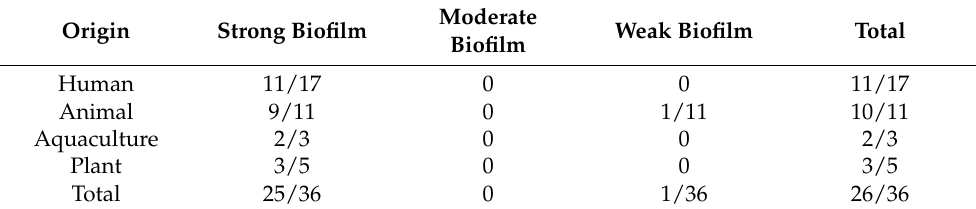
Table 1. The strength of biofilm formation among 36 Enterococcus